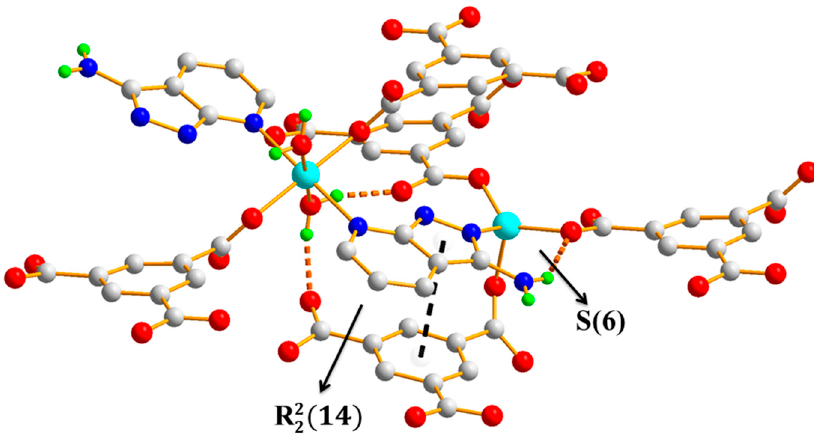
Figure 9. The hydogen bonding rings formed in Polymer 2.